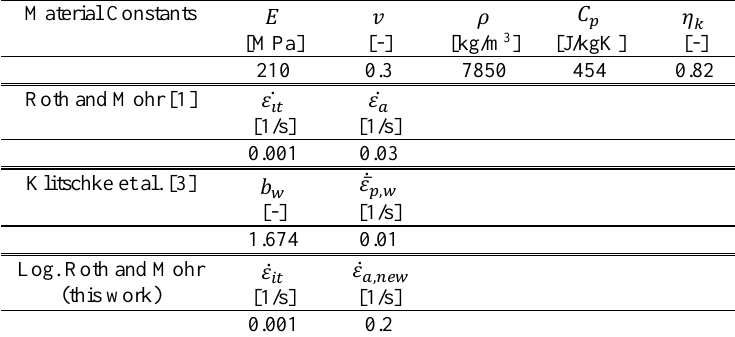
Table 1. Model parameters for